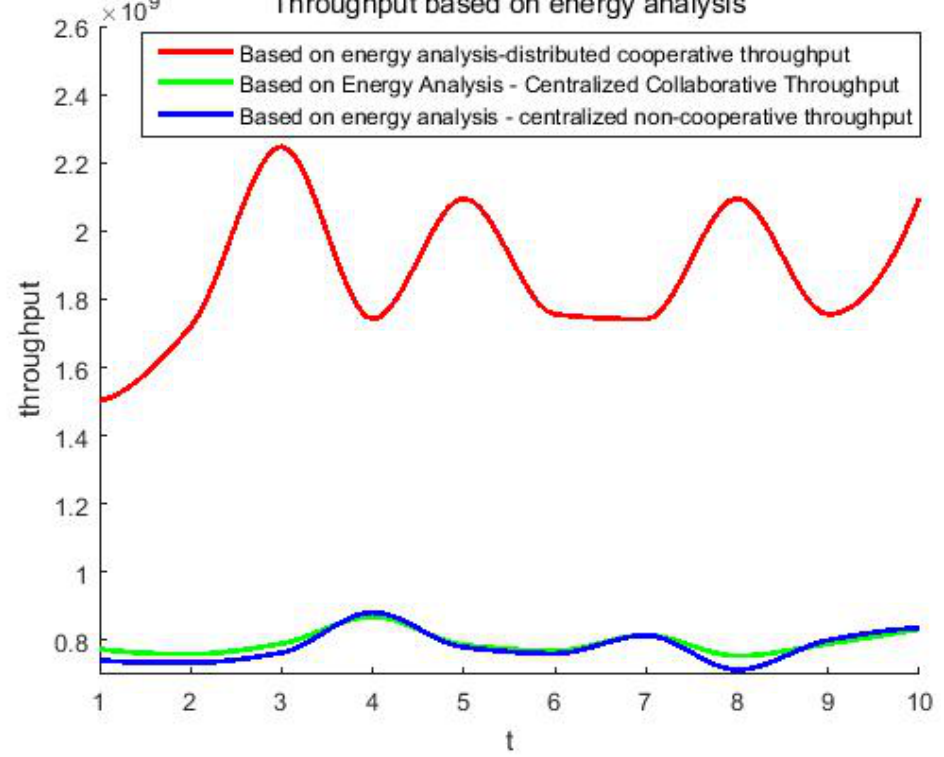
Figure 9. Throughput under different energy analysis-sensing methods.